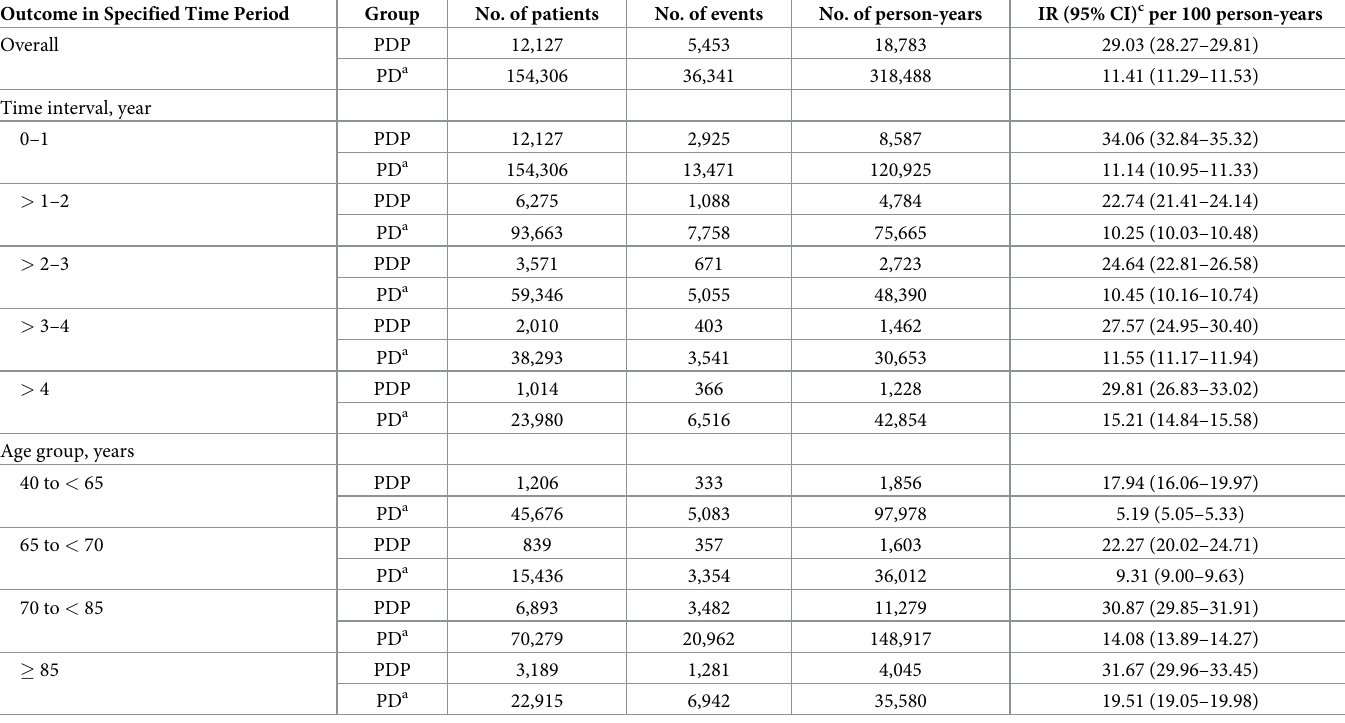
CI = confidence interval; IR = incidence rate; PD = Parkinson disease; PDP = Parkinson disease with psychosis. a All patients with PD who did not have a first psychosis diagnosis on their PD eligibility date. b Patients who met the criteria to enter the PDP cohort. c The number of events was assumed to follow a Poisson distribution; corresponding exact 95% CIs were computed using methods described in Dobson et al. [15].